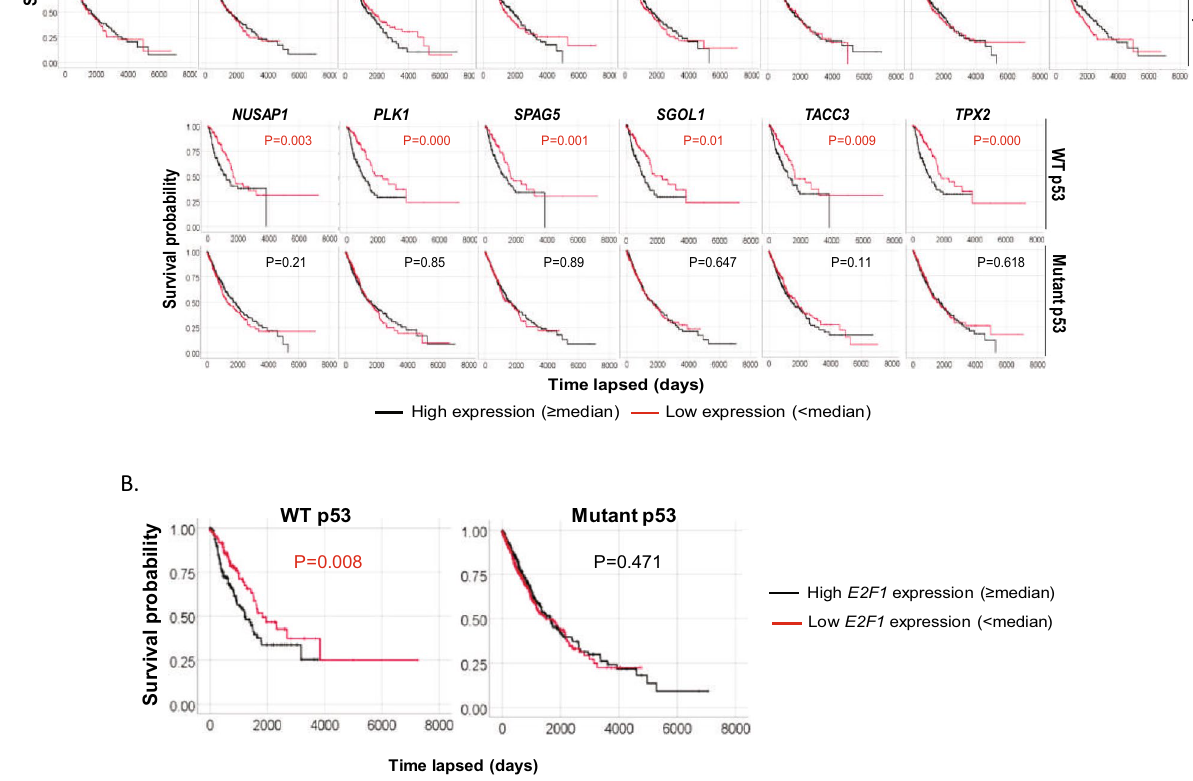
Figure 2. AURKA/B pathway genes associates with prognosis in WT p53 NSCLC patients. ( A ) Expression of the individual AURKA/B pathway genes that negatively correlates with RBL2 in NSCLC patients are tested for correlation with survival in all 994 NSCLC patients. High expression (≥ median) of each gene significantly associates with worse survival in WT p53 but not Mutant p53 patients (p values indicated). ( B ) High expression (≥ median) of E2F1 significantly associates with worse outcomes in WT p53 but not Mutant p53 patients (p values